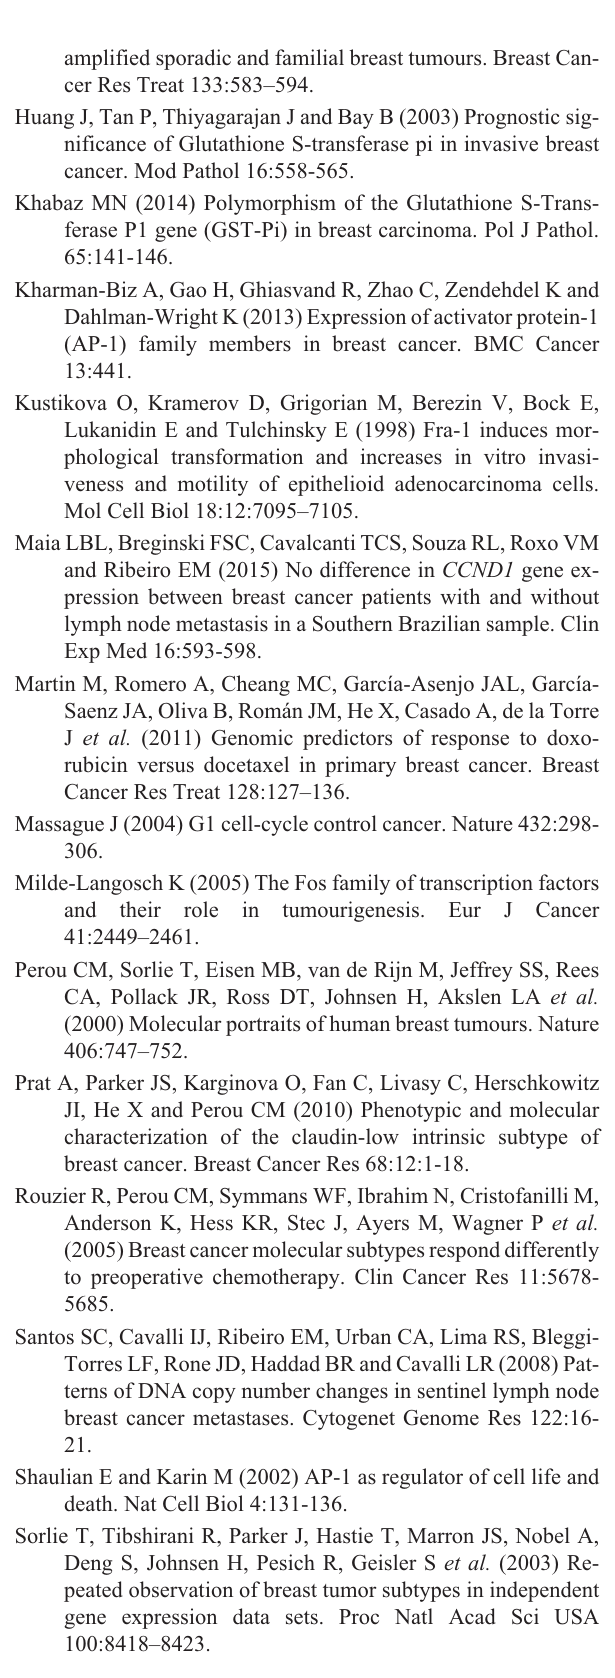
Table S1 - Clinico-pathological information, classification, follow up and DNA copy number of 73